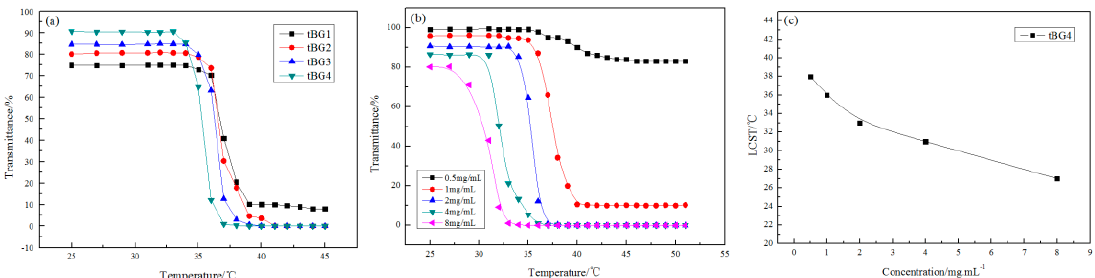
Figure 4. Transmittance tBG1–tBG4 in aqueous solution ( a ), the transmittance with different concentration tBG4 aqueous solution ( b ), and the low critical solution temperature (LCST) curve with different concentration of the tBG4 aqueous solution ( c ).